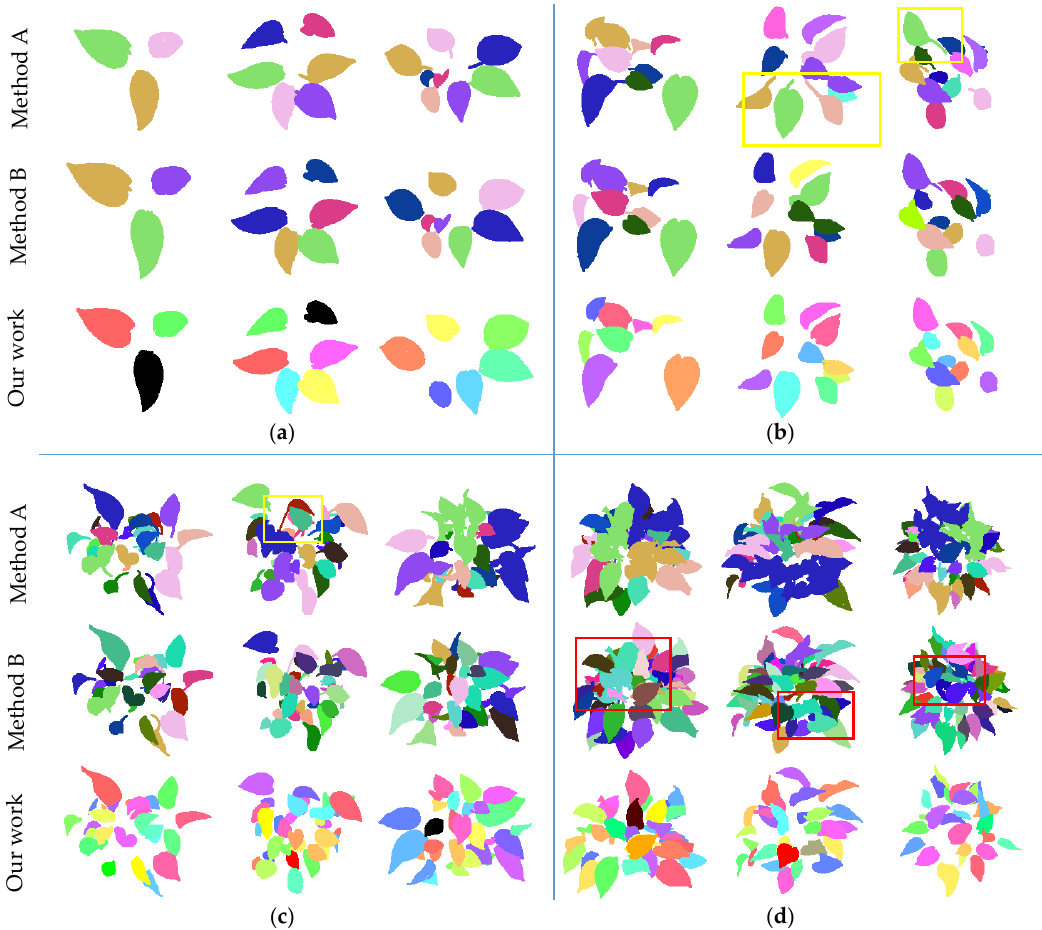
Figure 12. Segmentation results of two segmentation methods and our proposed method. Method A is the Euclidean Clustering method in papers [24,29] and B is the Facet Region Growing method in paper [27]. Plants in ( a ), ( b ), ( c ), and ( d ) are plants with no, a little, medium, and heavy canopy occlusion. The yellow boxes mark some segmented results of leaves with stems using the Euclidean Clustering method. The red boxes mark some segmented results of attached and overlapped leaves using the Facet Region Growing method. Table 7. Measurement accuracies of the scale-related morphological traits using the Euclidean Clustering method, Facet Region Growing method, and our method.